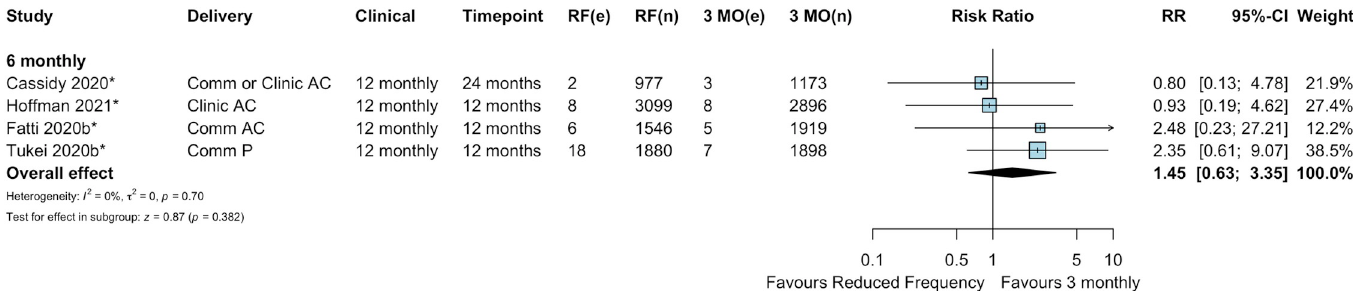
Fig 10. Mortality: Reduced frequency versus 3-monthly refills. � Cluster-adjusted RR. 3 MO, 3-monthly; AC, adherence club; Comm, community; e, number of events; n, number of participants; P, pharmacy; RF, reduced frequency; RR, risk ratio.